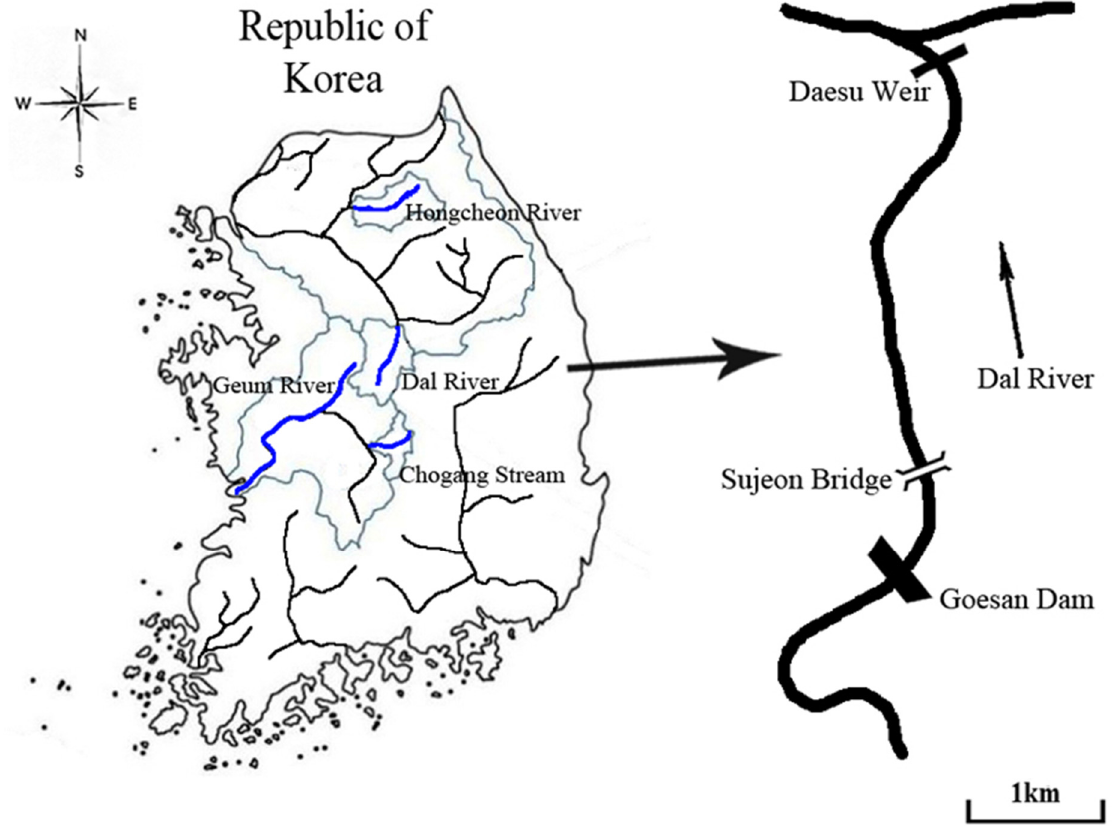
Figure 1. The Dal River and its neighboring